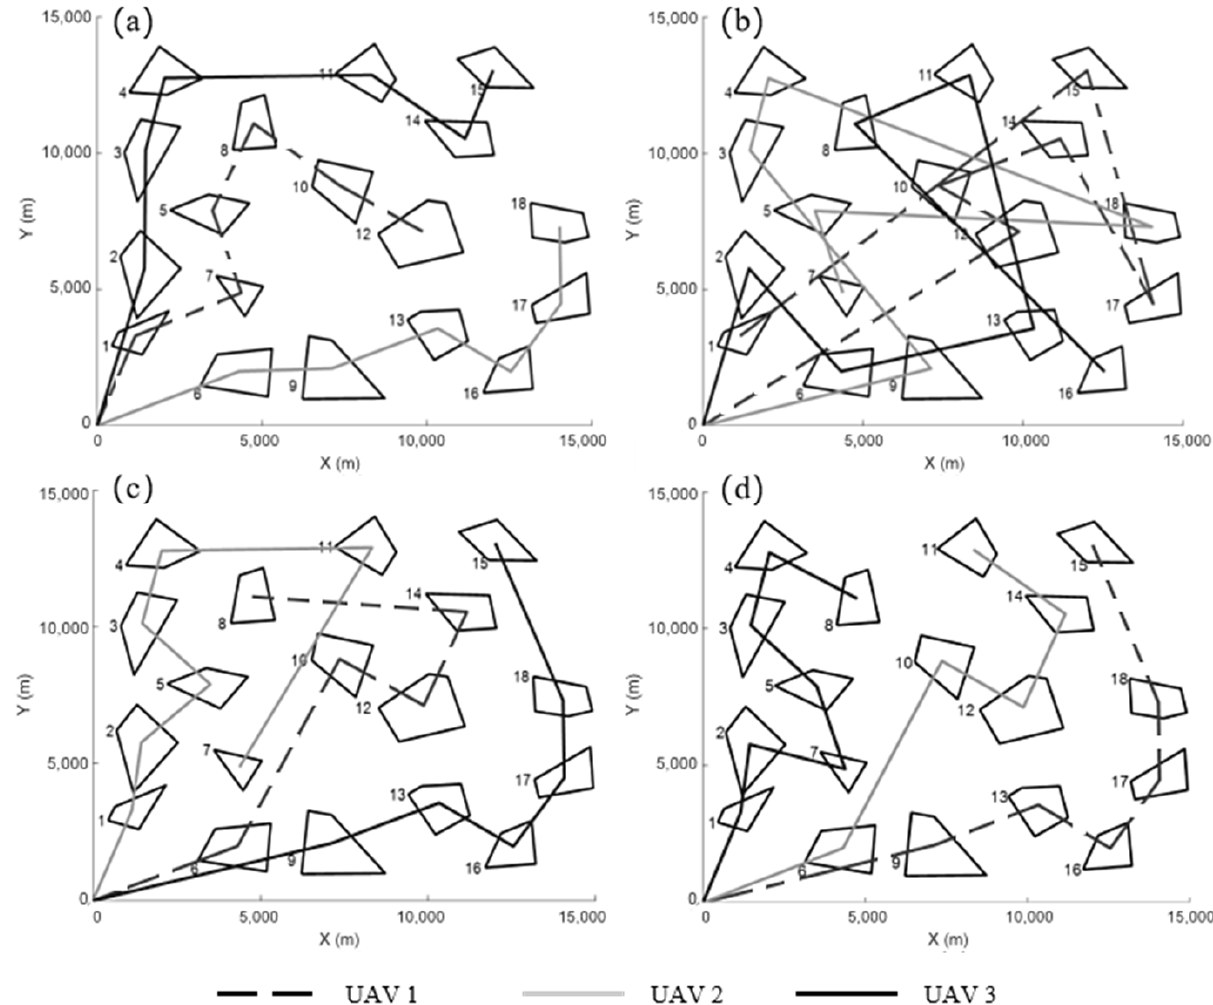
Figure 6. The CPP of homogeneous UAVs for four algorithms: ( a ) SDF, ( b ) LAF, ( c ) HETRF, ( d )